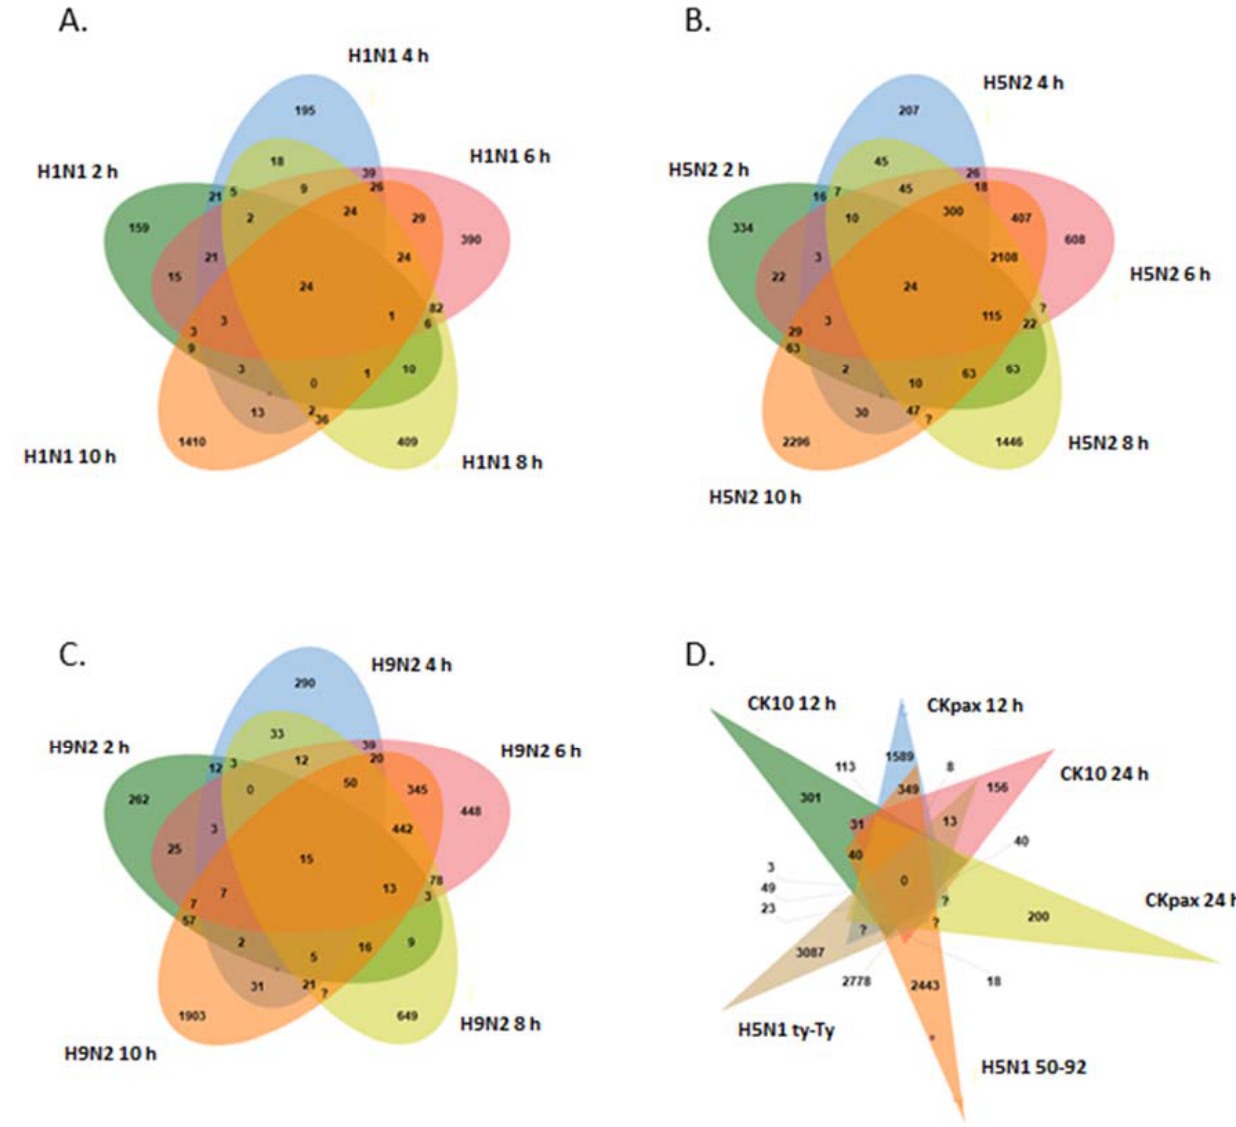
Figure 4. Venn diagram showing common genes across datasets and viral strains. ( A ) H1N1 across 2, 4, 6, 8 and 10 h, ( B ) H5N2 across 2, 4, 6, 8 and 10 h, ( C ) H9N2 across 2, 4, 6, 8 and 10 h, ( D ) H5N1.